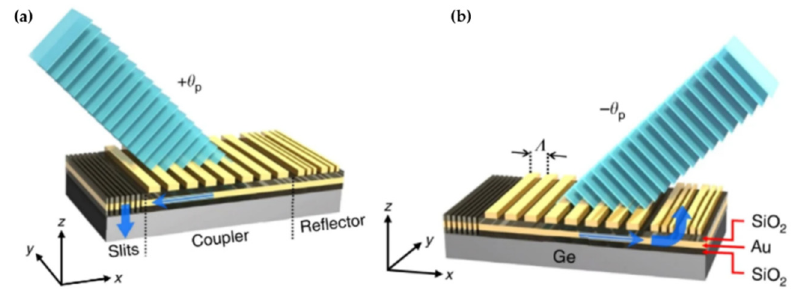
Figure 19 . ( a , b ) The structure of metasurface. Reproduced from [70]. CC By 4.0. Table 5. The parameters and the performance of the artificial compound eye using plasmonic metasurface-based lens. Author